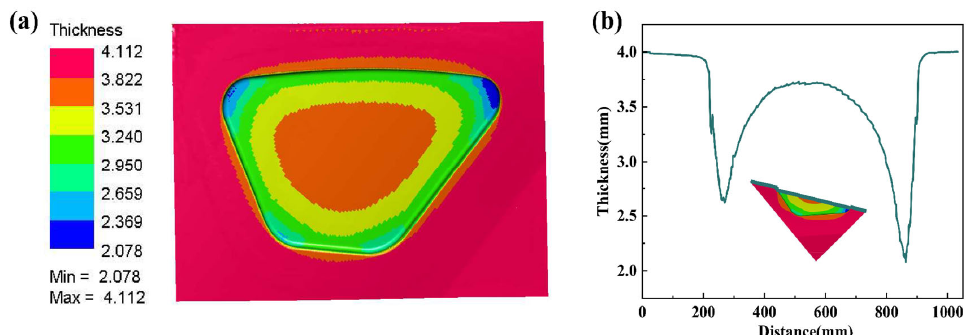
Figure 4. Simulation result ( a ) Numerical simulation cloud diagram of direct superplastic forming; ( b ) Thickness variation of the part along the section.